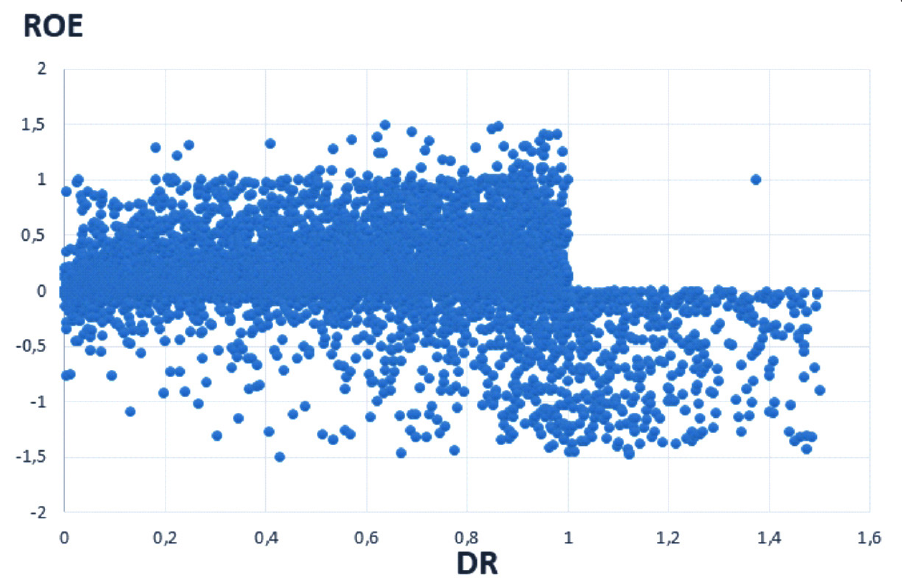
Figure 6. Scatter plot (ROE,